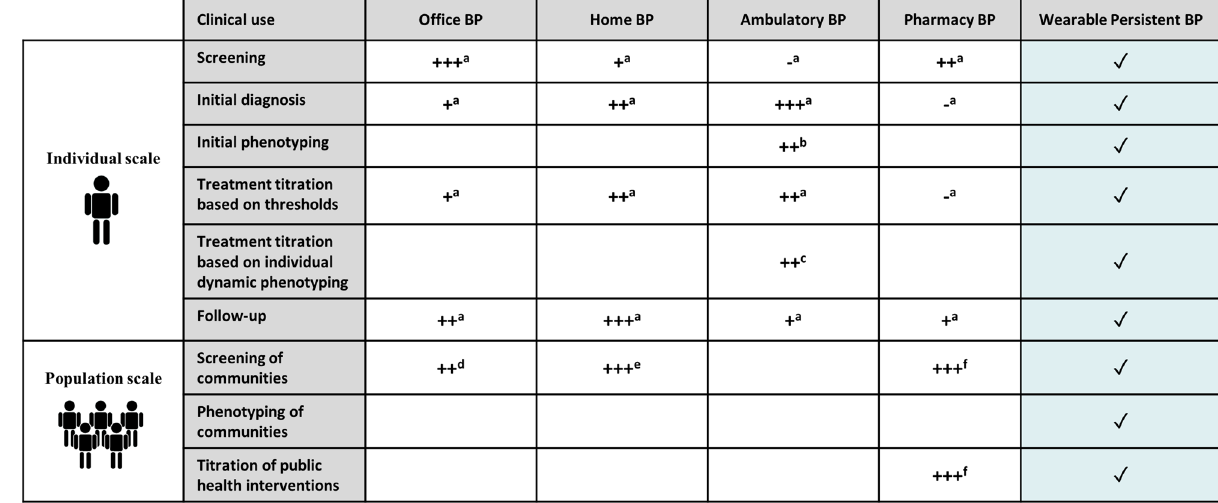
Table 1. Scores on the potential use and utility of office BP, home BP, ambulatory BP and pharmacy BP taken from 8 (marked by a ), 9 (marked by b ), 10 (marked by c ), 11 (marked by d ), 12 (marked by e ) and 13 (marked by f